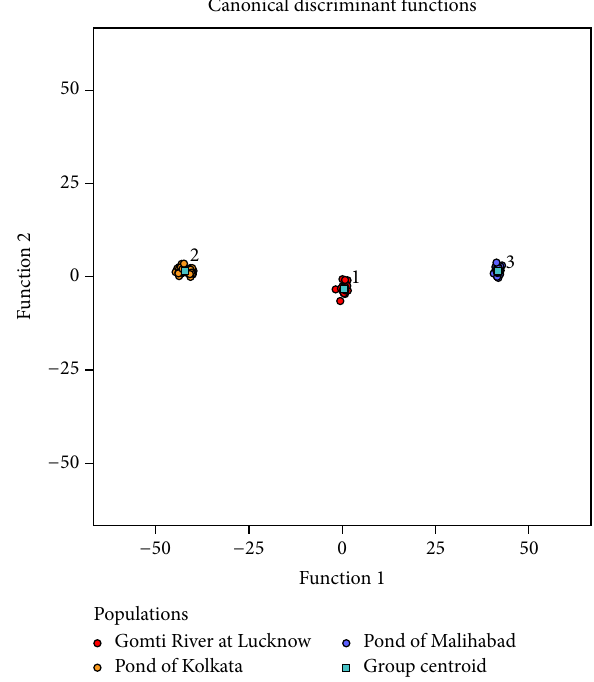
Figure 5: Group centroids of the three subpopulations of C. punctatus in DFA combined groups